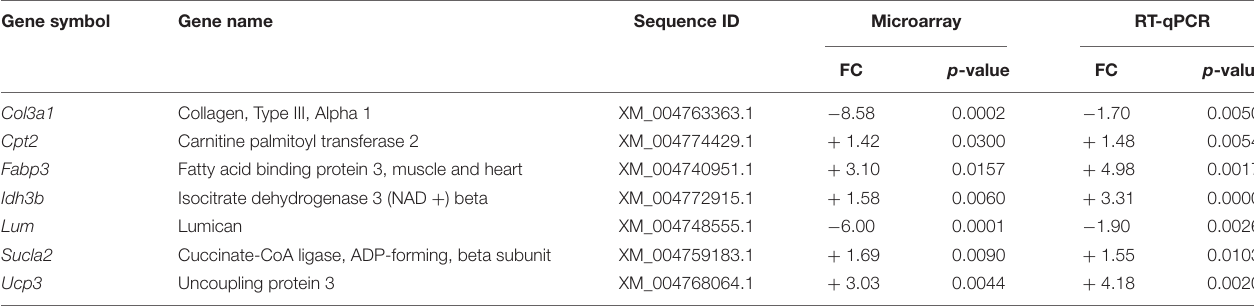
TABLE 4 | Real-time polymerase chain reaction confirmation of microarray